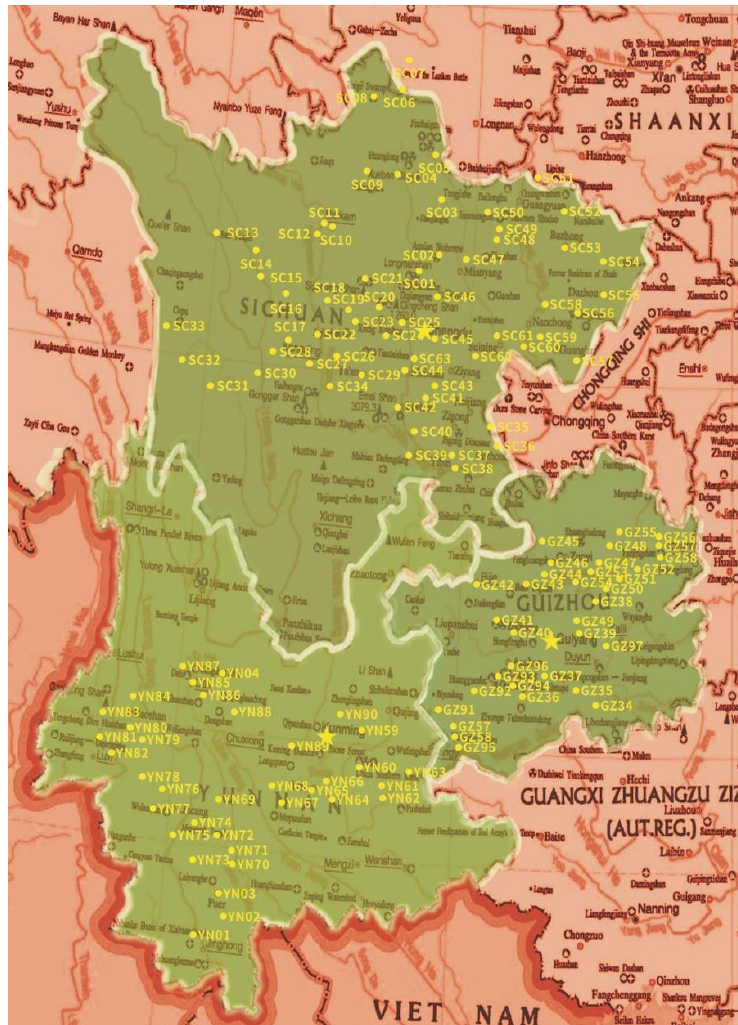
Figure 1. The map of sites distribution for the soil samples collection.